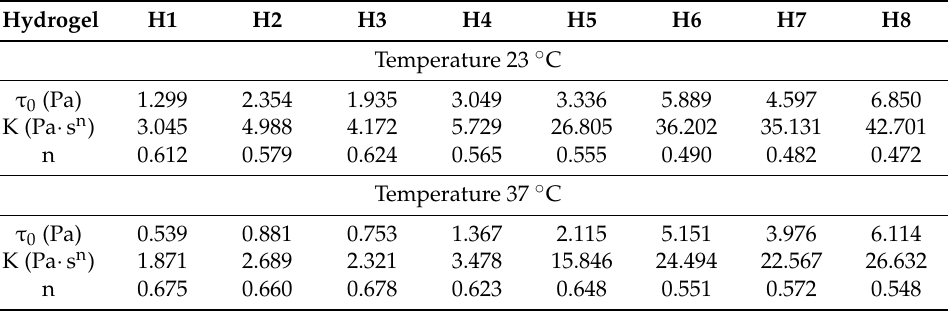
Table 2. Herschel-Bulkley parameters obtained in relation with forward rheograms for hydrogels tested at 23 ˝ C and 37 ˝ C.